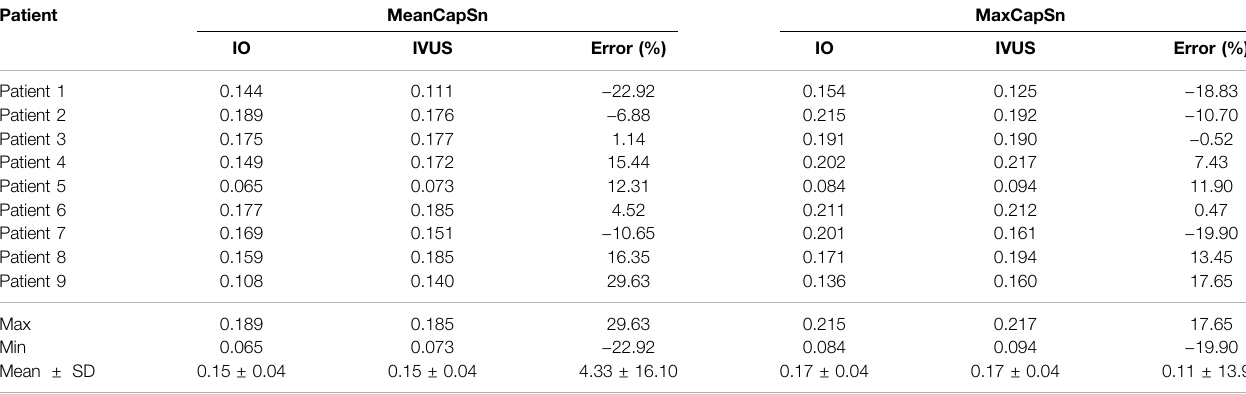
TABLE 4 | Summary of mean and maximum cap strain values for 9